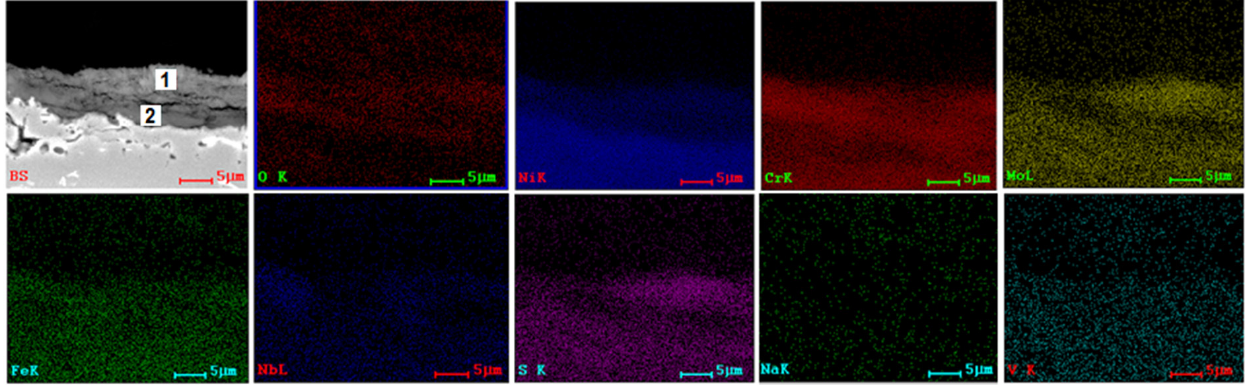
Figure 5. SEM image (BS) and EDS distribution maps of the elements corresponding to SEM image for cross section of 3DPP (900 °C, 96 h).